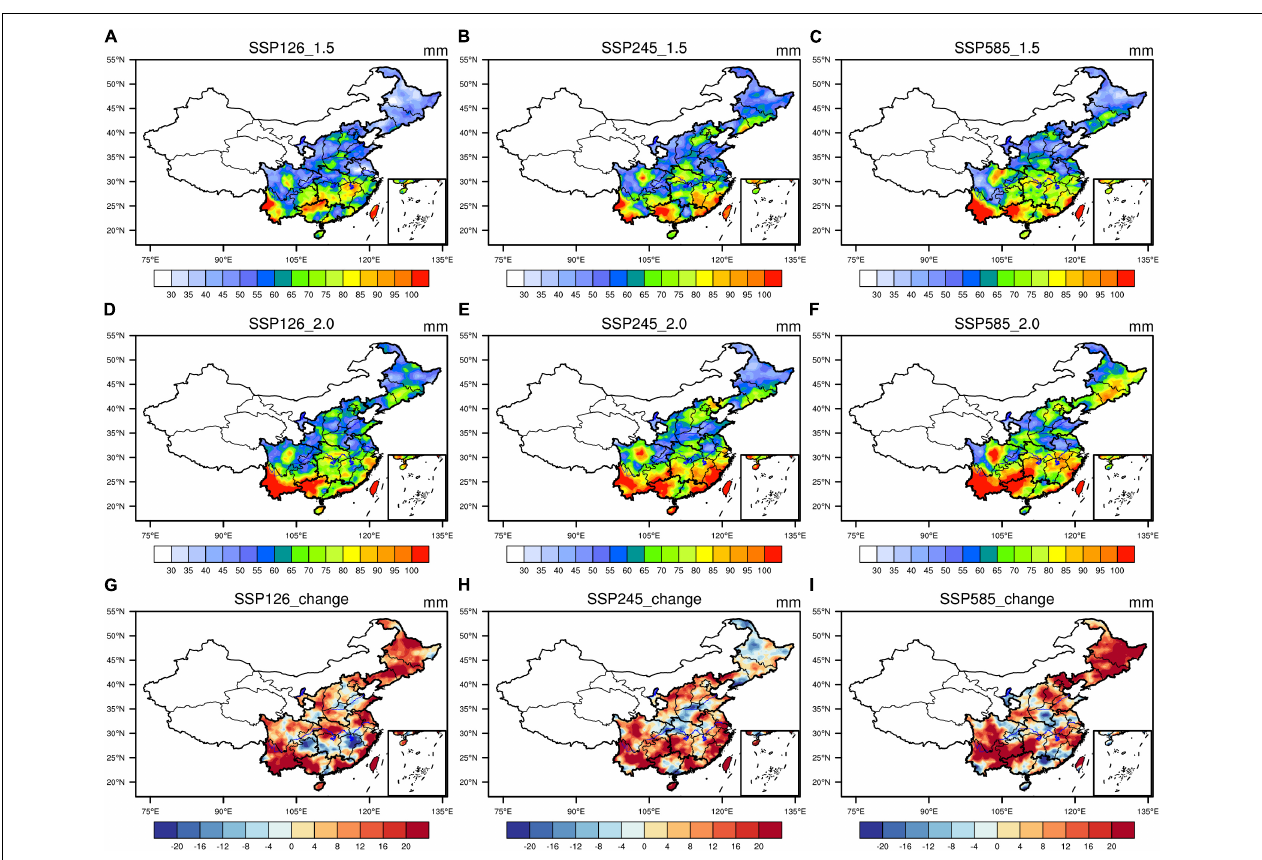
FIGURE 9 | Distribution of annual total extreme precipitation (R99pTOT) at 1.5 and 2 ◦ C. (A–C) Global warming at 1.5 ◦ C under SSP126, SSP245, and SSP585, respectively. (D–F) Global warming at 2 ◦ C under SSP126, SSP245, and SSP585, respectively. (G–I) The differences between global warming at 1.5 and 2 ◦ C.